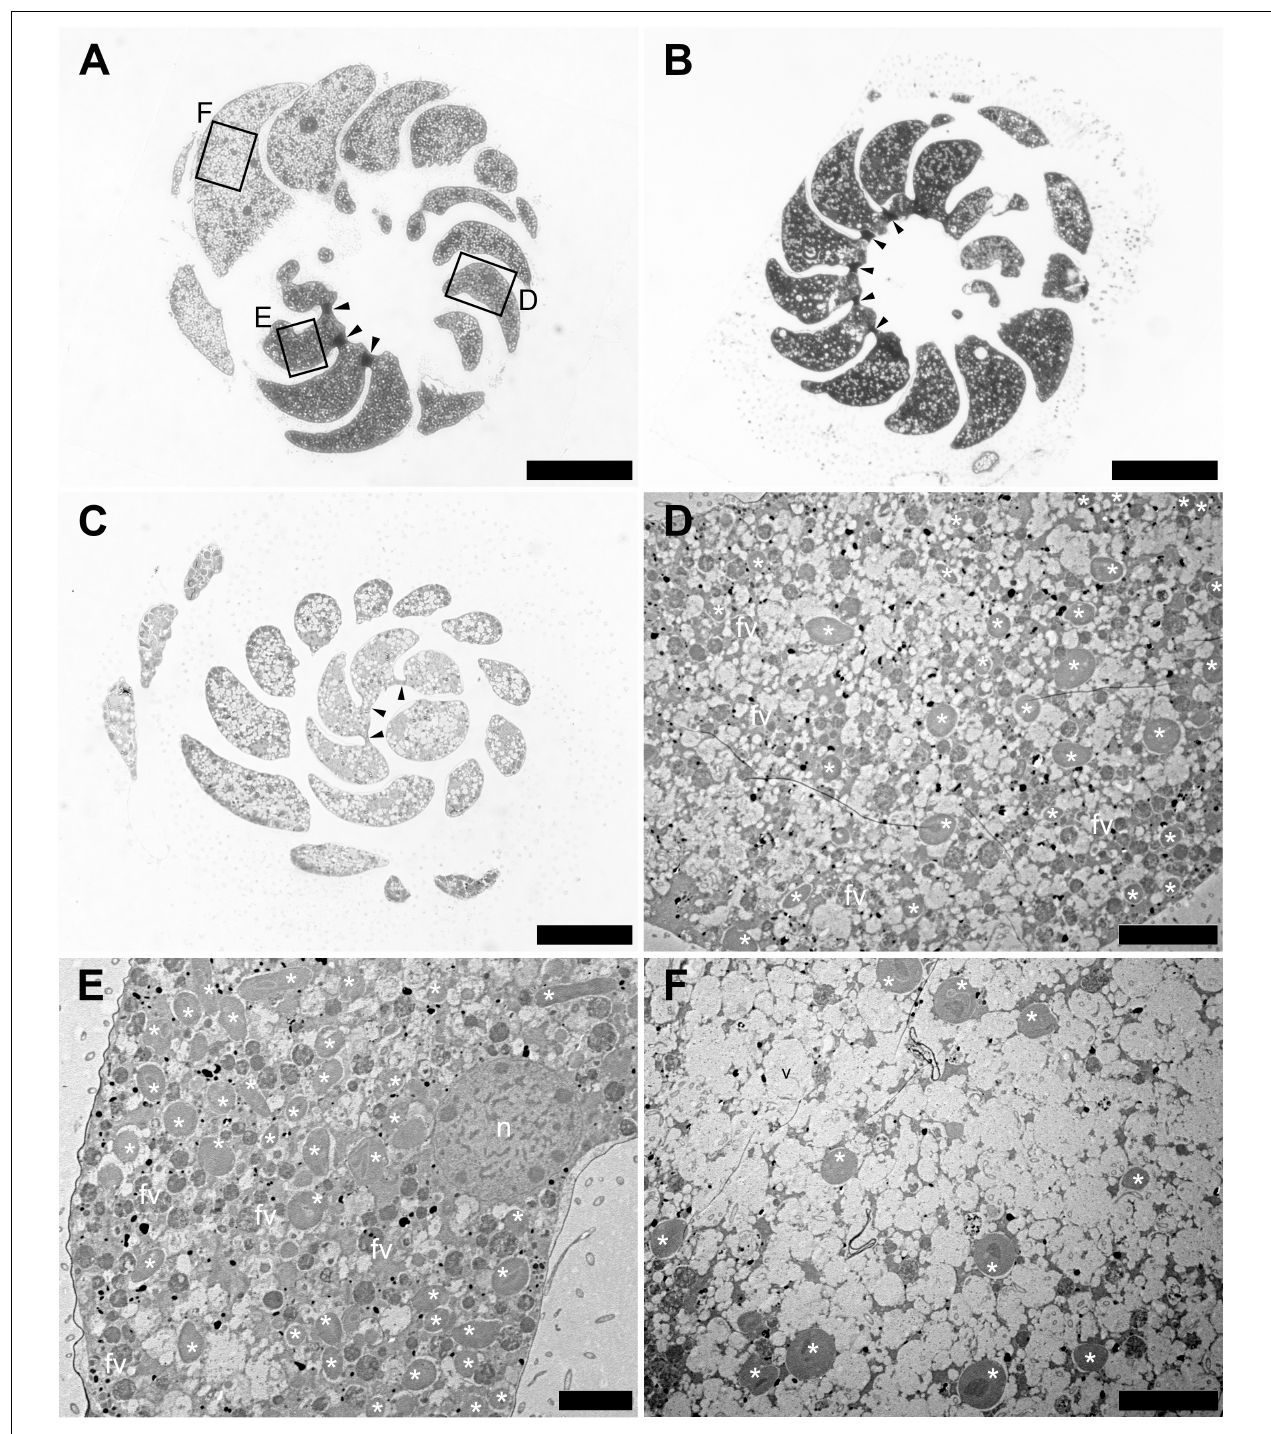
FIGURE 2 | Optical and Transmission electron micrographs (TEMs) of Planoglabratella opercularis . (A) Heterogeneous features of cytoplasm between chambers are separated by plugs (arrowheads). Squares indicate regions featured in the indicated panels of figures (D–F) . Scale bar = 100 µ m. (B) Homogeneous features of cytoplasm among chambers that are separated by plugs (arrowheads). Scale bar = 100 µ m. (C) Homogeneous features of cytoplasm among chambers that lack plugs between chambers (arrowheads). Scale bar = 50 µ m. (D–F) Higher Magnification TEMs, which are indicated as squares in figure (A) . (D) Kleptoplasts (*), food vacuoles (fv), and vacuoles are visible. Scale bar = 10 µ m. (E) Kleptoplasts (*) and food vacuoles (fv) are densely distributed. Scale bar = 5 µ m. (F) Numerous empty vacuoles are distributed throughout the chamber and a few kleptoplasts (*) are visible. Scale bar = 10 µ m.